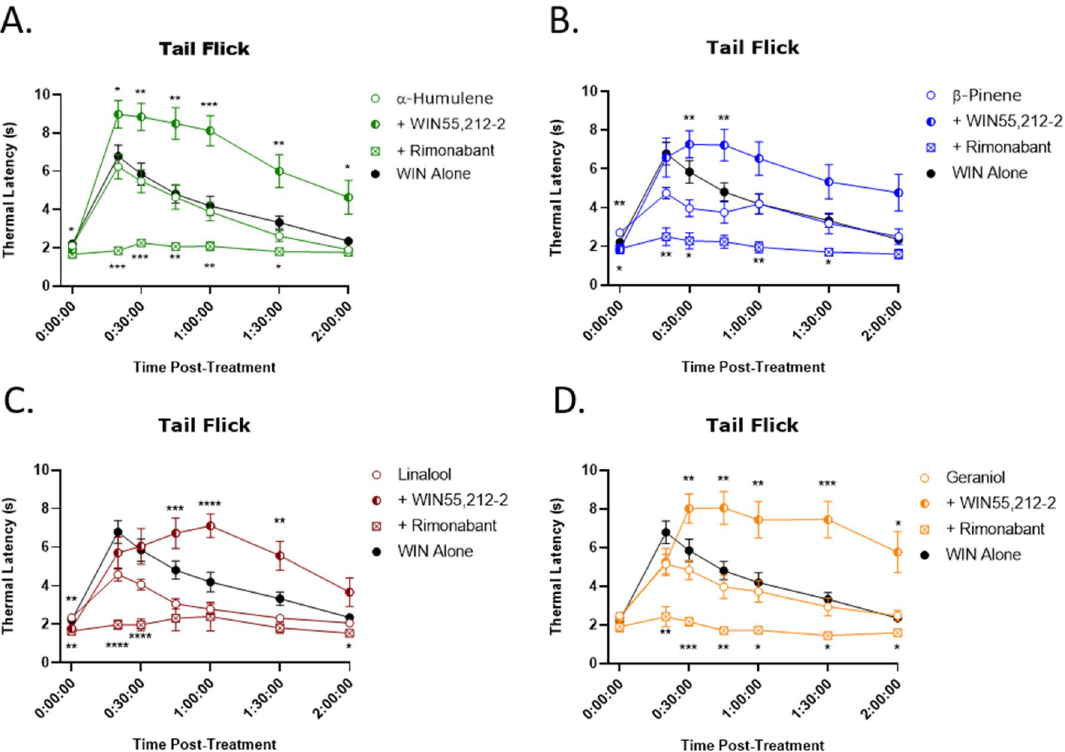
Figure 2. Terpenes Induce CB1 Dependent and Cannabinoid Additive Antinociception in the Tail Flick Assay. Mice were treated with 200 mg/kg terpene alone, combined with 5.6 mg/kg WIN55,212-2, or after pretreatment with 10 mg/kg rimonabant, all injected i.p. . Mice were then assessed in the tail flick test over 2 h. ( A ) α-Humulene, ( B ) β-Pinene, ( C ) Linalool and ( D ) Geraniol. Data represents the mean ± SEM of tail flick latency (n = 10–14/group). Statistics analyzed via RM two-way ANOVA, Dunnett’s post hoc; * p < 0.05, ** p < 0.01, *** p < 0.001, **** p < 0.0001, compared to terpene alone at same time point. The animal response to 5.6 mg/kg WIN55,212-2 (“WIN Alone”) from Fig. S1 is included in each graph for